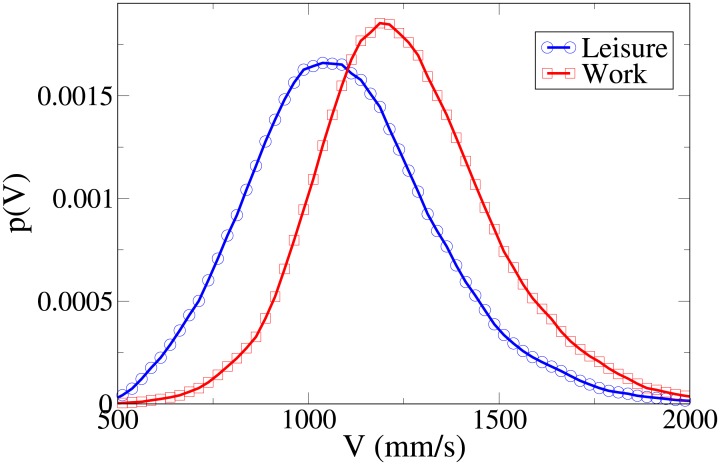
Pdf of the V observable according to purpose.Blue, centre of bin identified by circles: leisure oriented dyads. Red and squares: work oriented dyads. All pdfs in this work are shown after having been smoothed with a moving average filter.